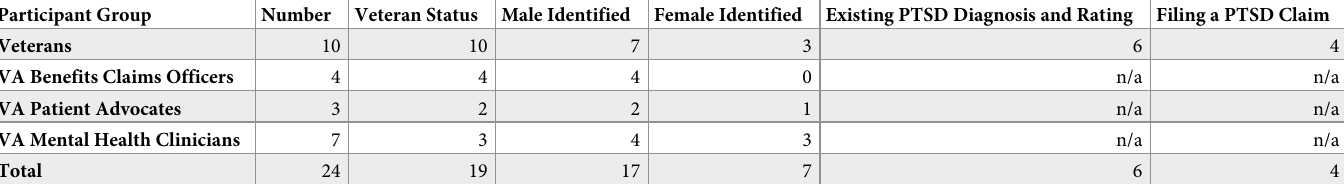
Table 2. Participant